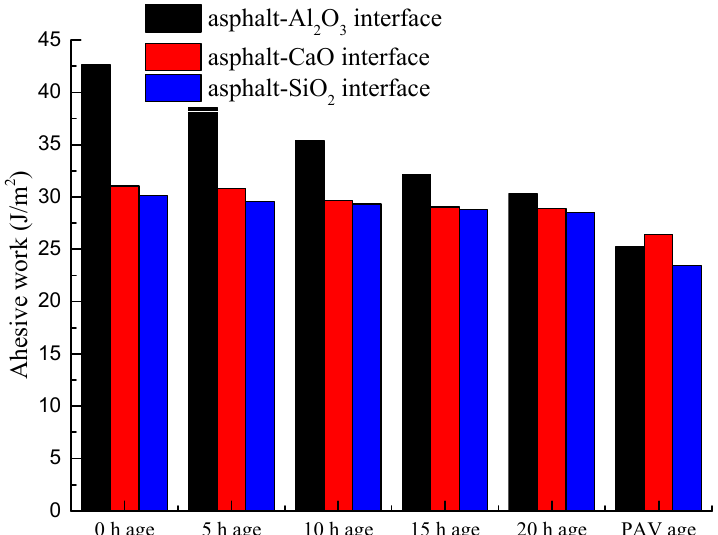
Figure 7. Adhesive work of asphalt-binder-aggregate mineral interface.